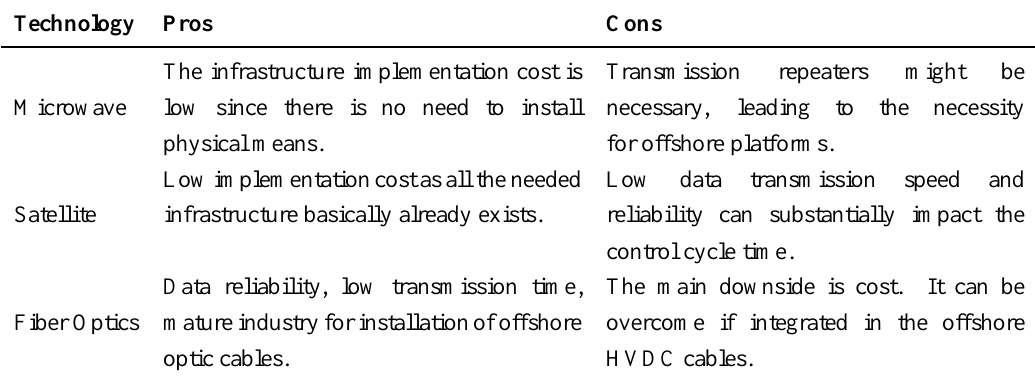
Table 4. Comparison of telecommunication technologies for the DVC